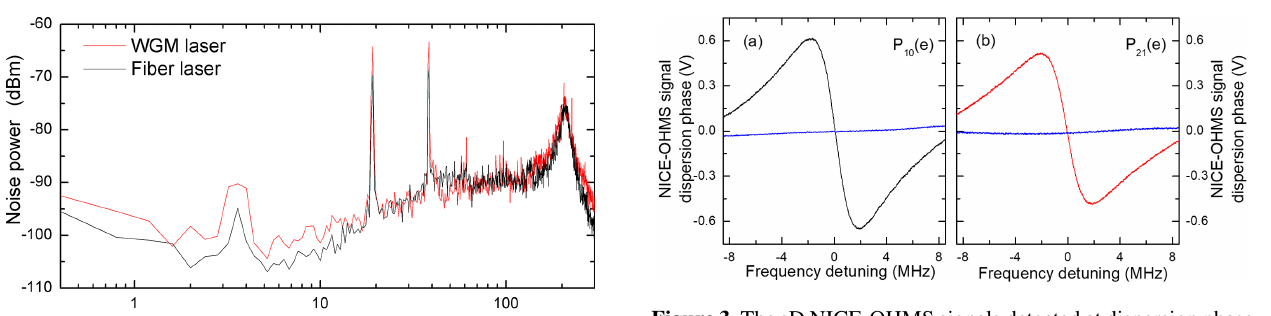
Figure 3. The sD NICE-OHMS signals detected at dispersion phase on the P 10 (e) and P 21 (e) transitions from 13.3Pa of acetylene de- tection by an EDFL and a WGM laser, respectively. The blue lines in both panels are the background signals when the cavity was evac-